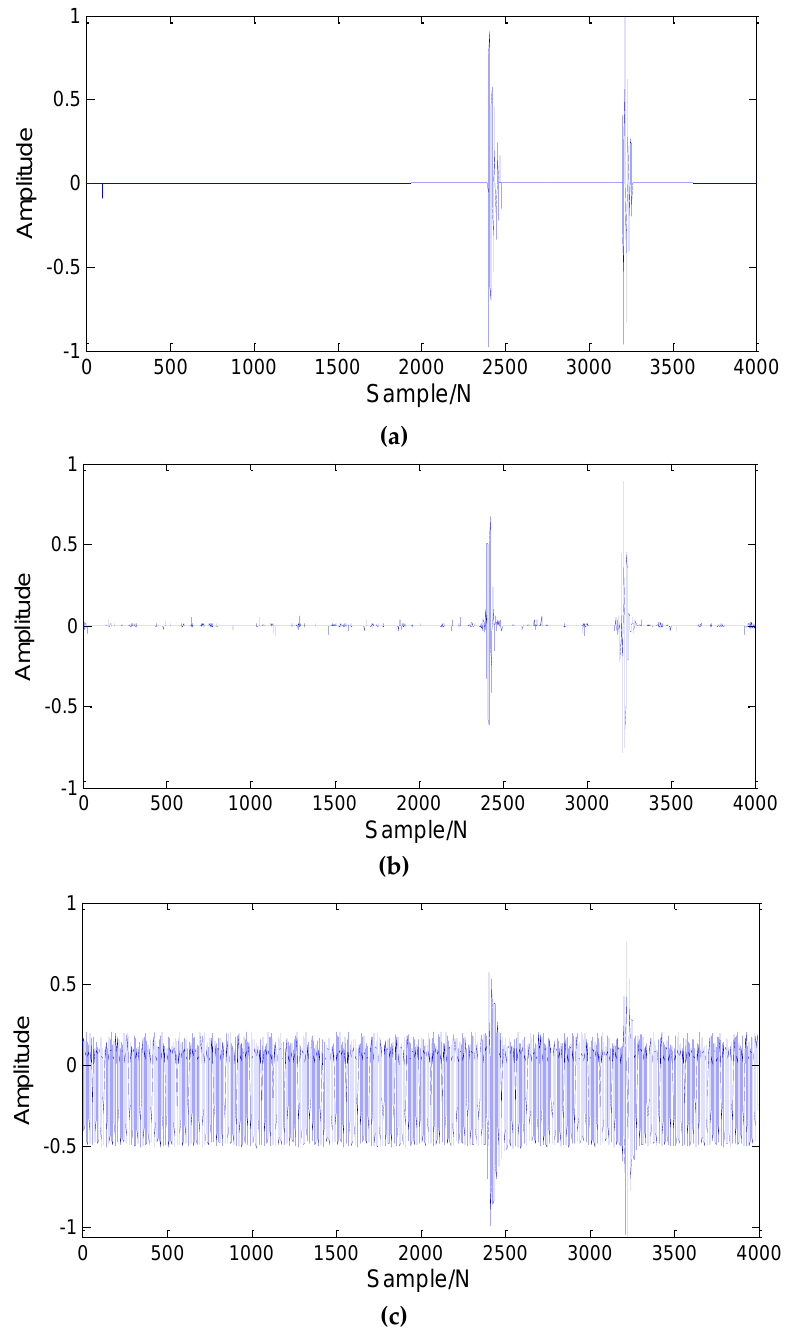
Figure 6. Comparison of PD signal extraction results: ( a ) Proposed CEEMDAN-Hankel-SVD method; and ( b ) Complete ensemble empirical mode decomposition (CEEMD)-based method; and ( c ) Variation mode decomposition (VMD) wavelet threshold method.